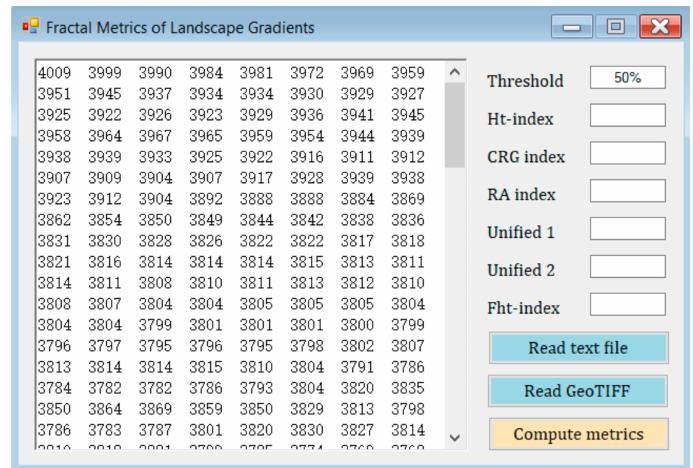
Figure 5. The developed tool for easily computing fractal